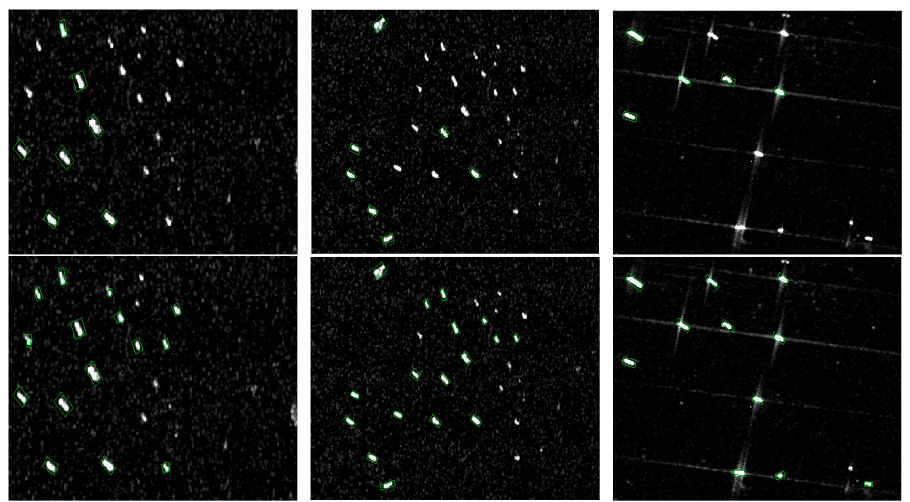
Figure 7. Results of the semantic fusion and attention module. The top row shows the detector without the semantic fusion and attention module; the bottom row shows the detector with the semantic fusion and attention module.